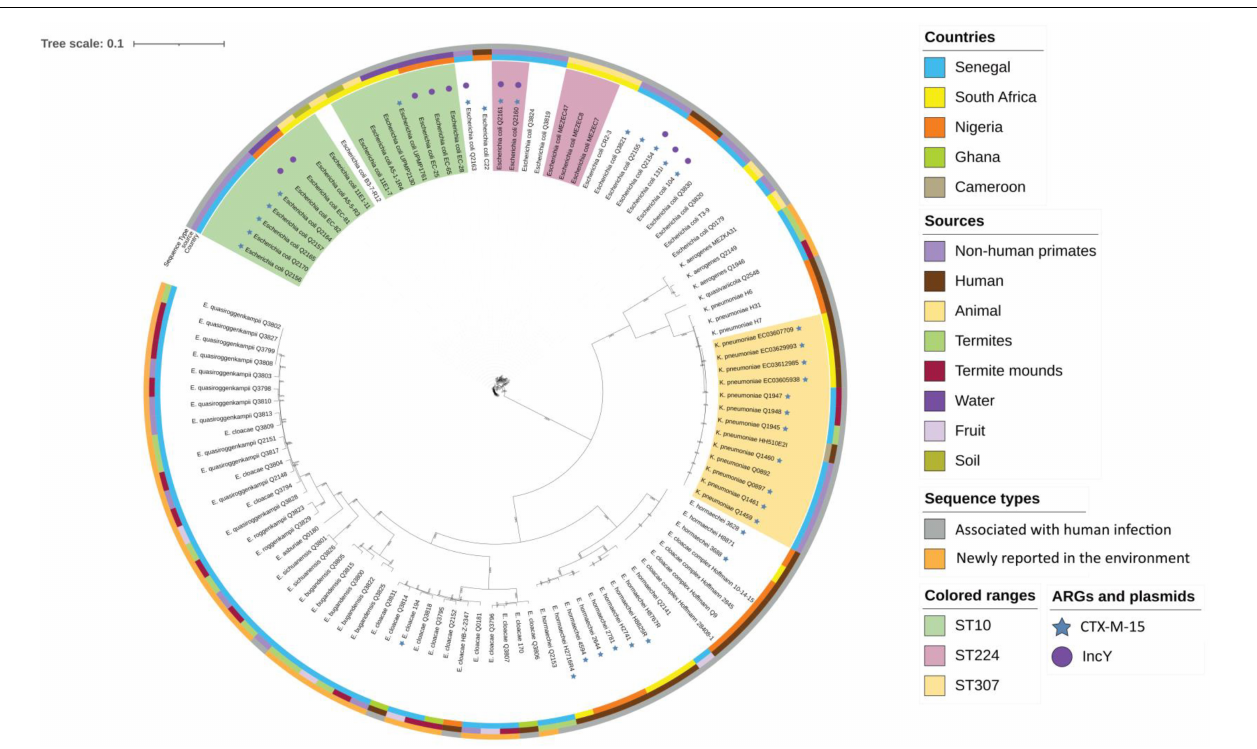
FIGURE 3 | Maximum likelihood phylogenetic tree representation of the 9 Klebsiella spp., 16 E . coli , and 37 Enterobacter spp. strains compared with strains from different origin of the Sub-Saharan region. The tree was generated and annotated with the iTOL tool